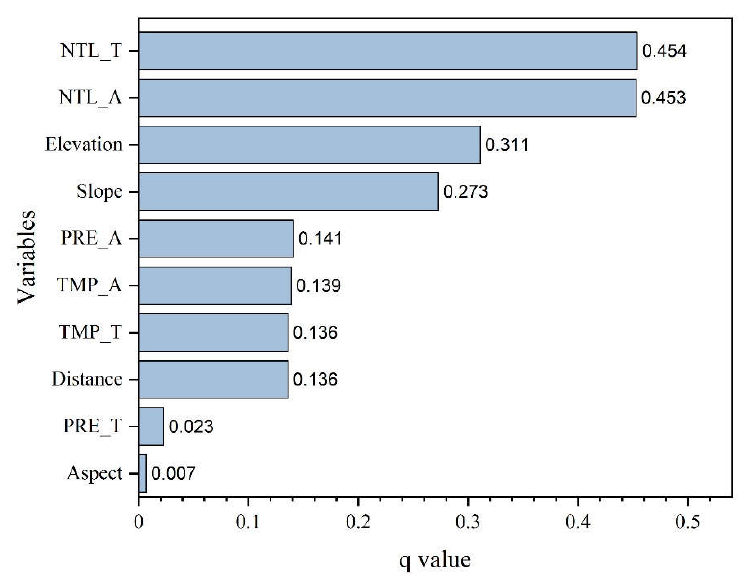
Figure 5. Relative importance of driving factors.